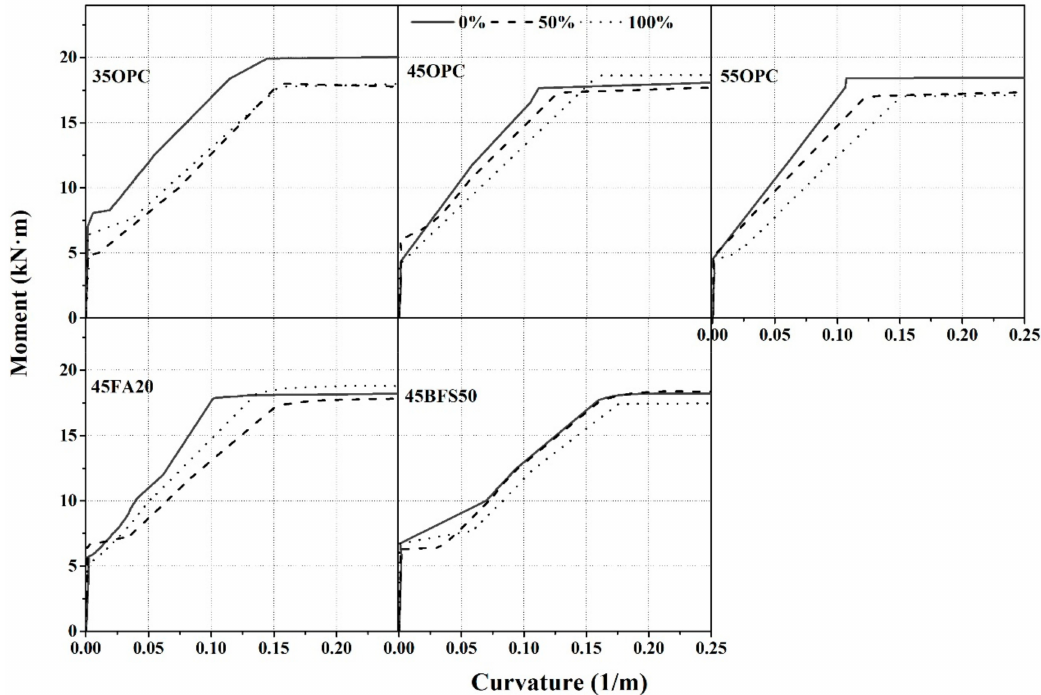
Figure 6. Moment-curvature curve for RC